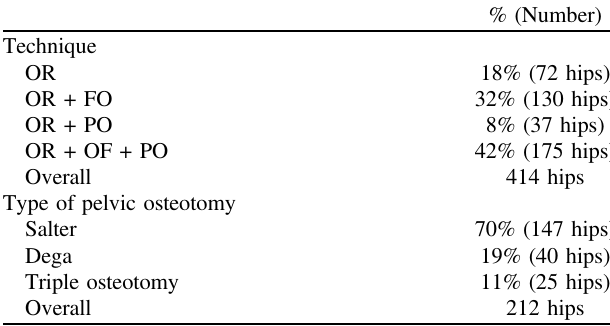
Table 1. Summary of surgical